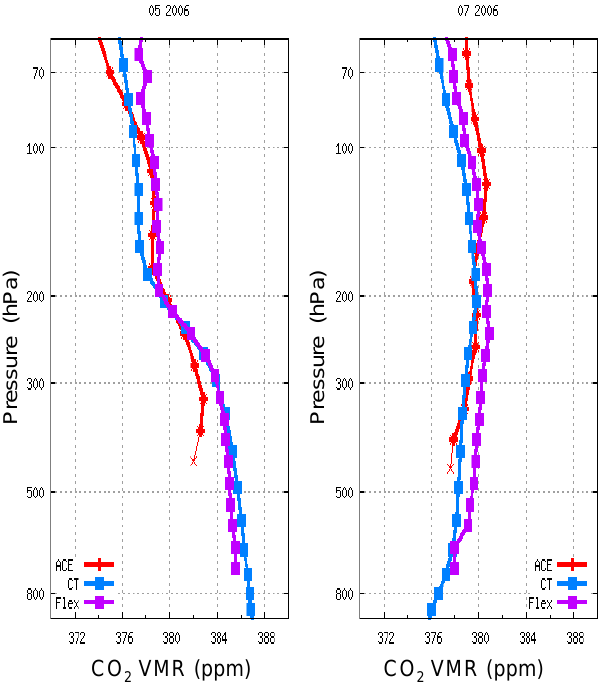
Fig. 9. Same as Fig. 7 for